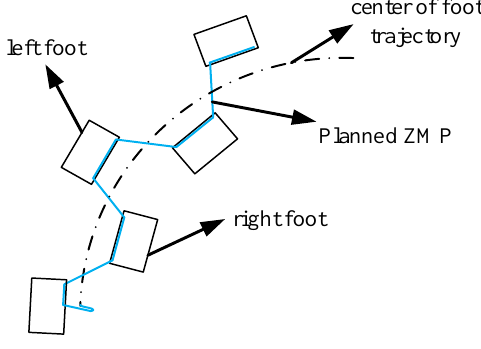
Figure 11. ZMP planning for the robot turning